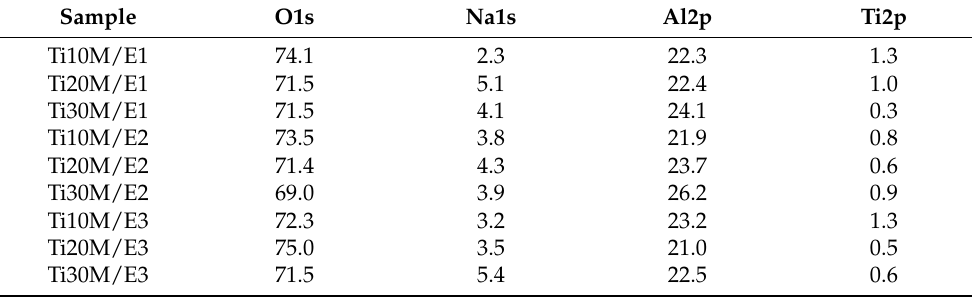
Table 1. Element relative concentrations